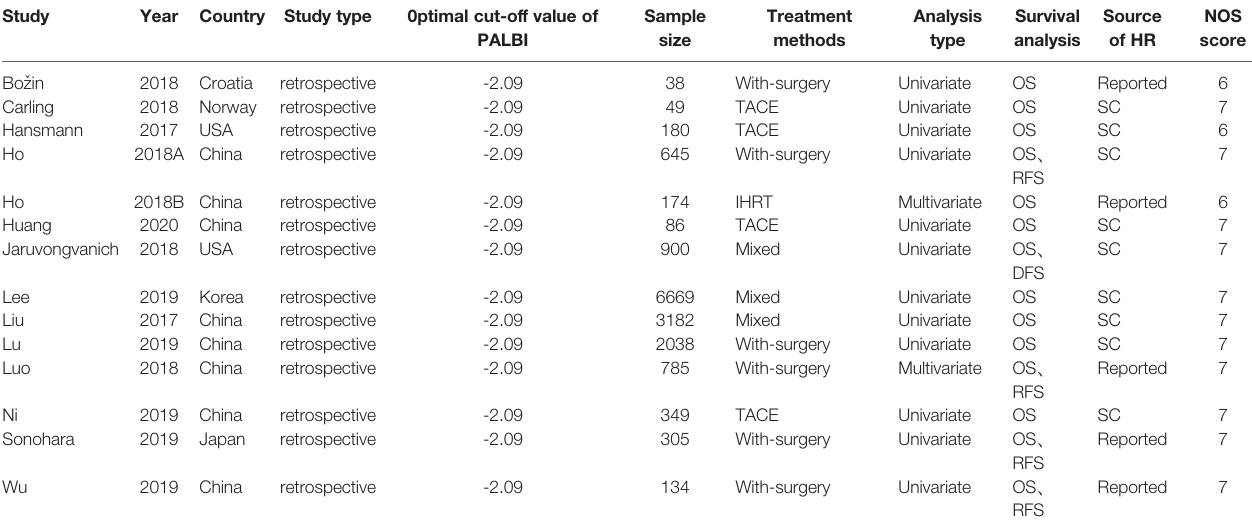
Basic information of included studies.